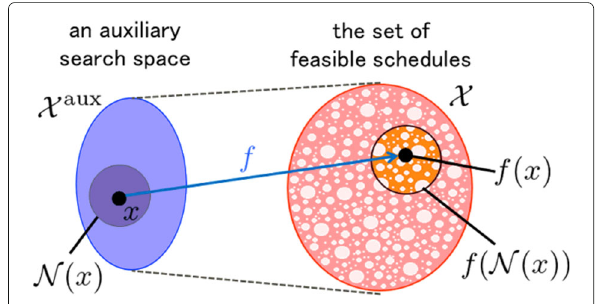
Fig. 3 Indirect search